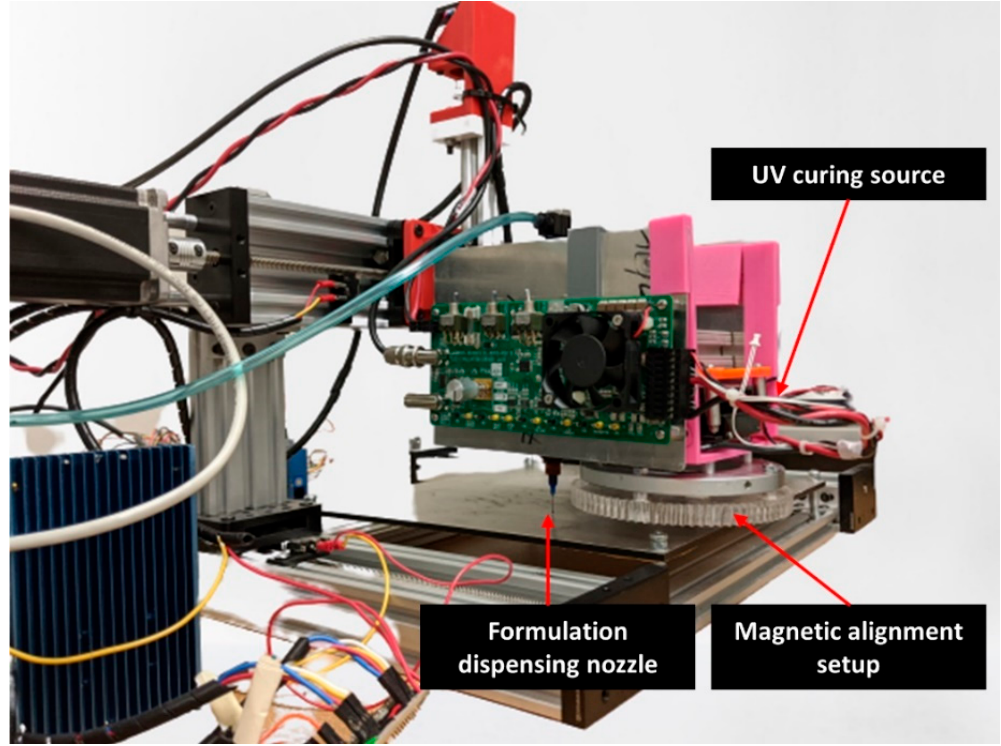
Figure 8. Material jetting equipment with the in-situ particle alignment system, representing manufacturing scenario (B) in Figure 7.